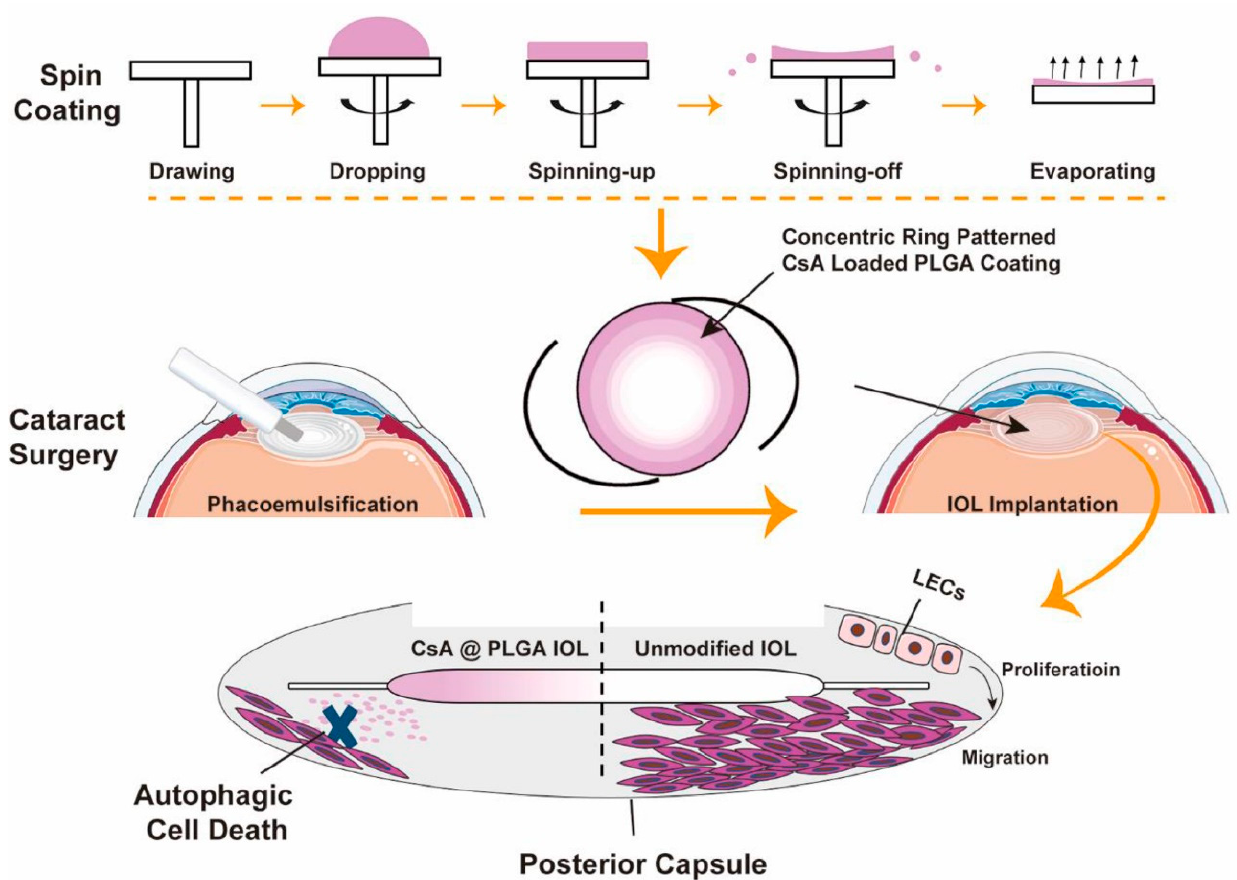
Figure 8. Schematic illustration of intraocular lens modified by centrifugally concentric ring-patterned drug-loaded PLGA coating for posterior capsular opacification prevention. Adapted with permission from Ref. [104]. Copyright 2022 Elsevier.